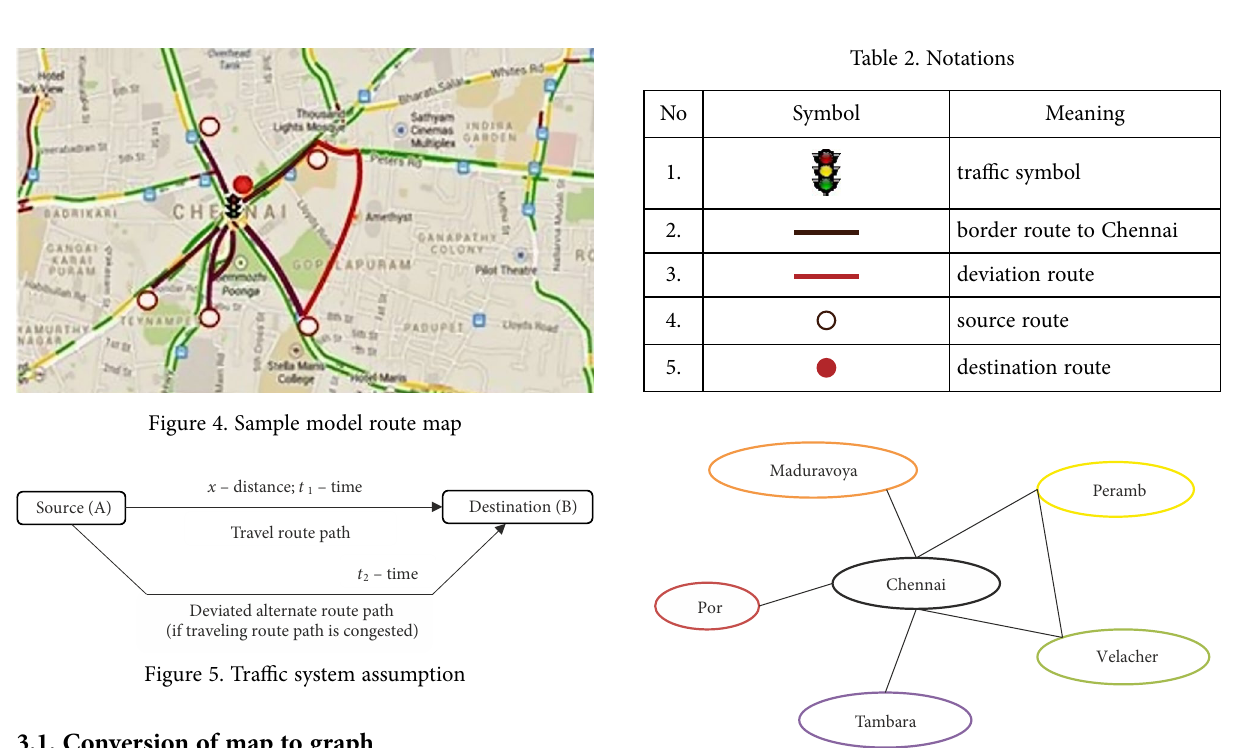
Figure 3. Work flow of proposed framework